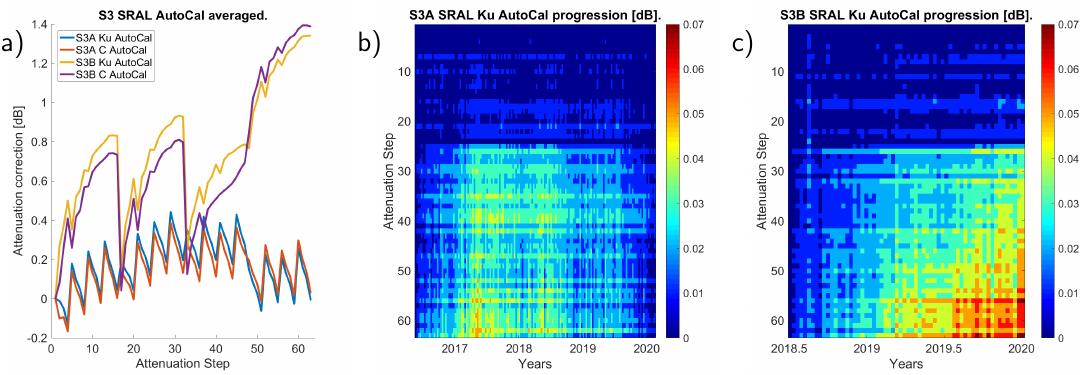
Figure 8. AutoCal correction of S3A and S3B missions: ( a ) averaged mission attenuation (measured minus reference), ( b ) S3A attenuations progression with respect to first record, and ( c ) S3B attenuations progression with respect to first